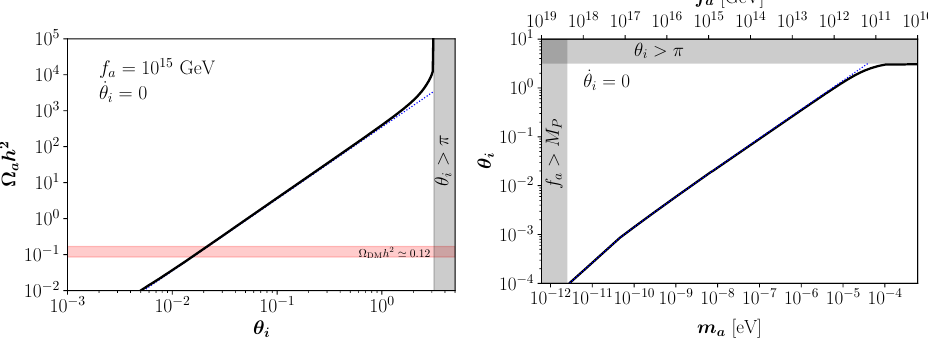
Figure 1. Standard scenario. Left panel : Axion relic abundance for f a = 10 15 GeV, taking ˙ θ i = 0. Right panel : Misalignment angle required to match the whole observed DM abundance. The two lines show the comparison between numerical (solid black) and analytical (dotted